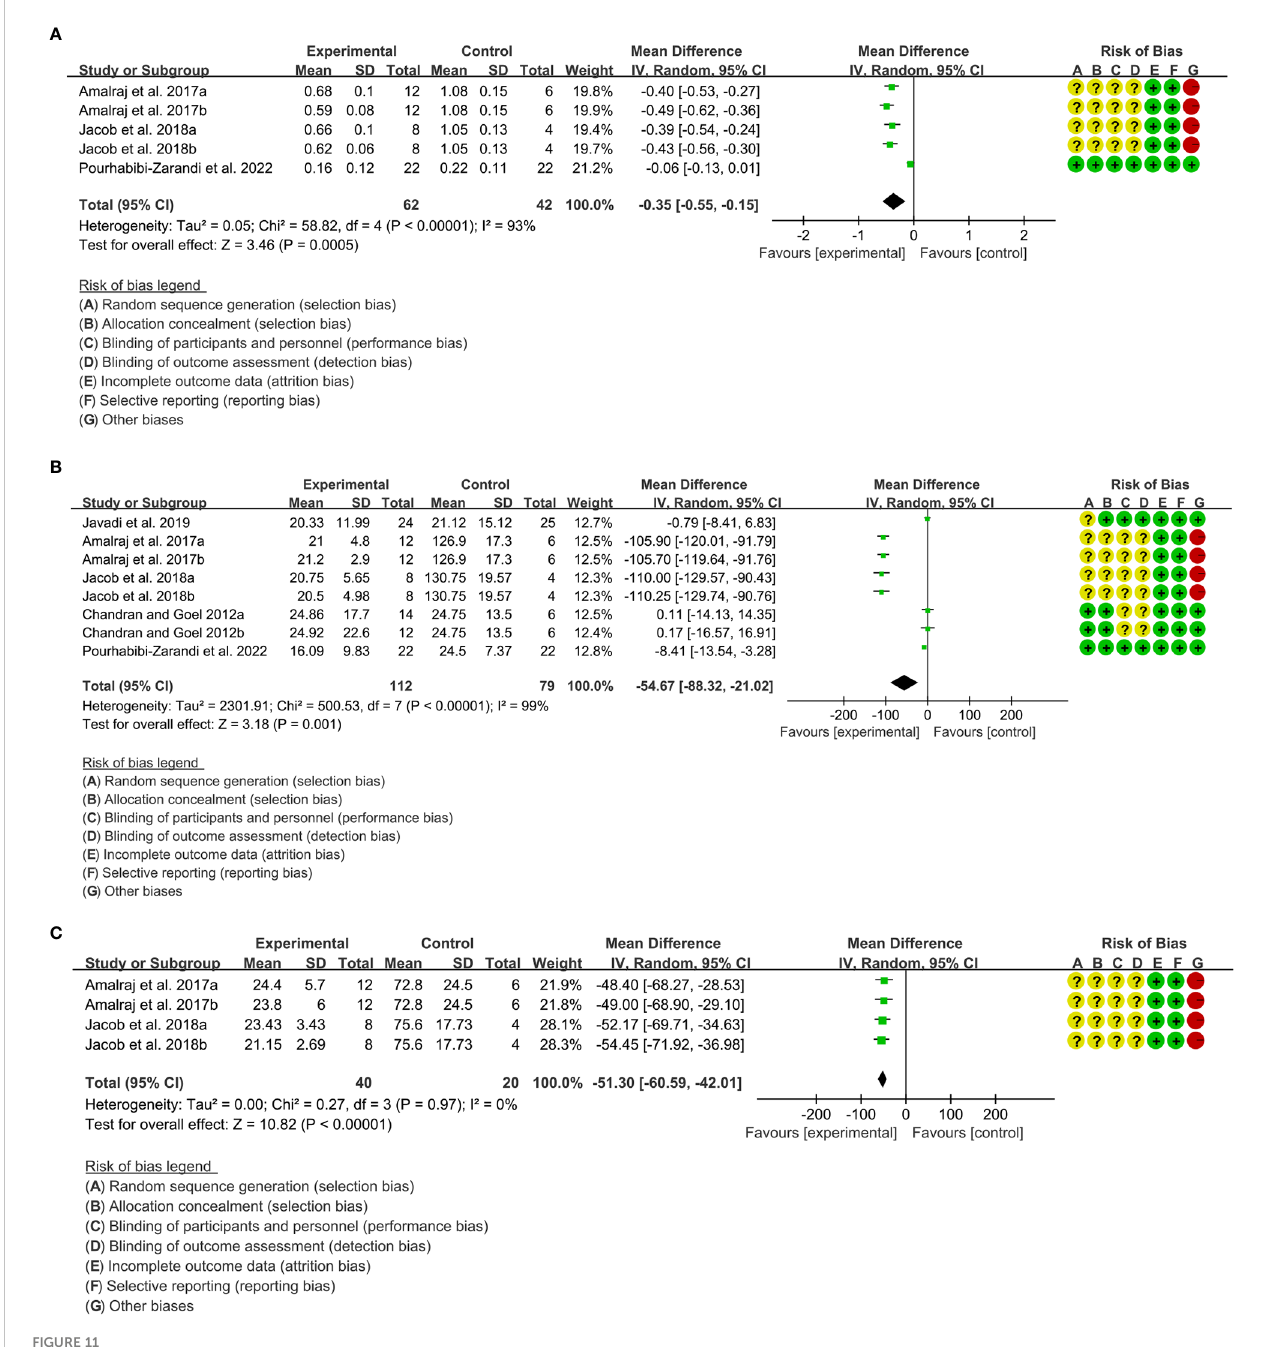
FIGURE 11 In fl ammatory parameters of curcumin (A) CRP; (B) ESR; (C)